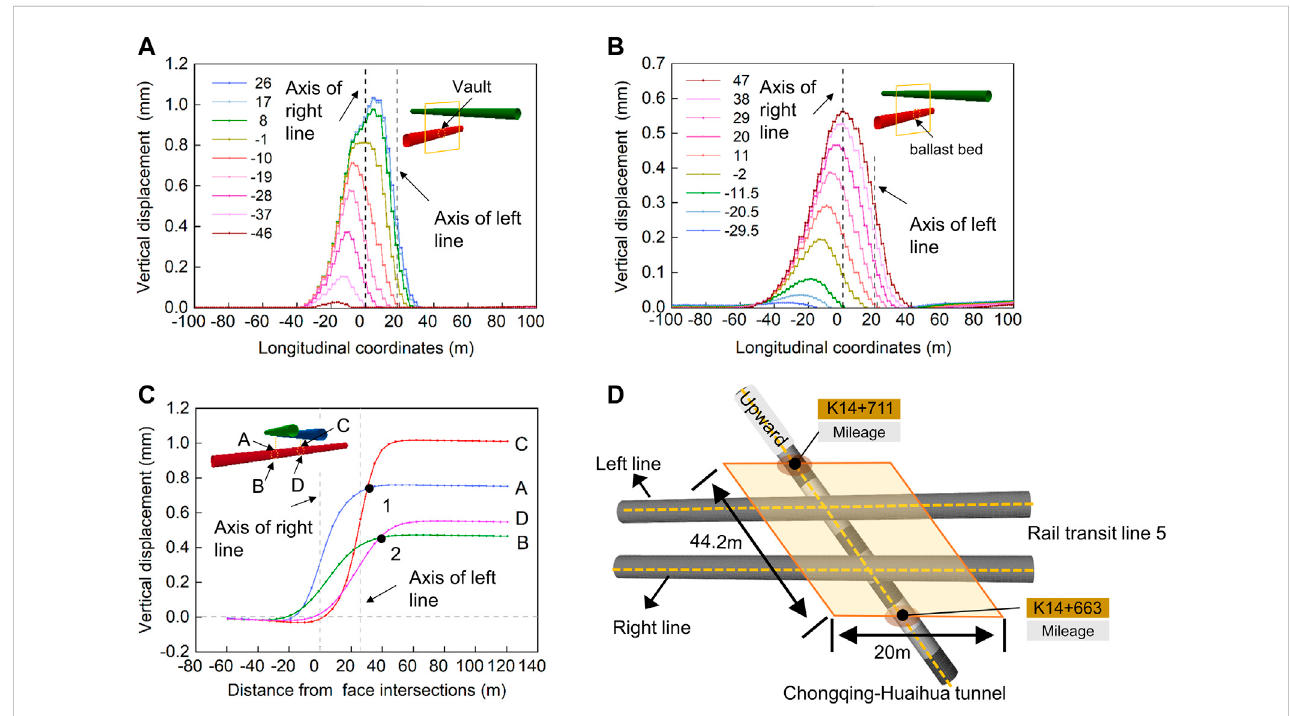
Displacement curve and in fl uence scope of the operational tunnel. (A) Vault. (B) Ballast bed. (C) Cross section. (D) In fl uence